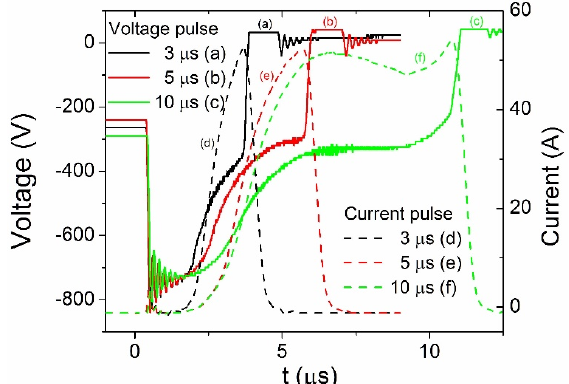
Figure 1. Discharge voltage and current waveforms of reactive HiPIMS deposition of Si target with varying pulse duration.